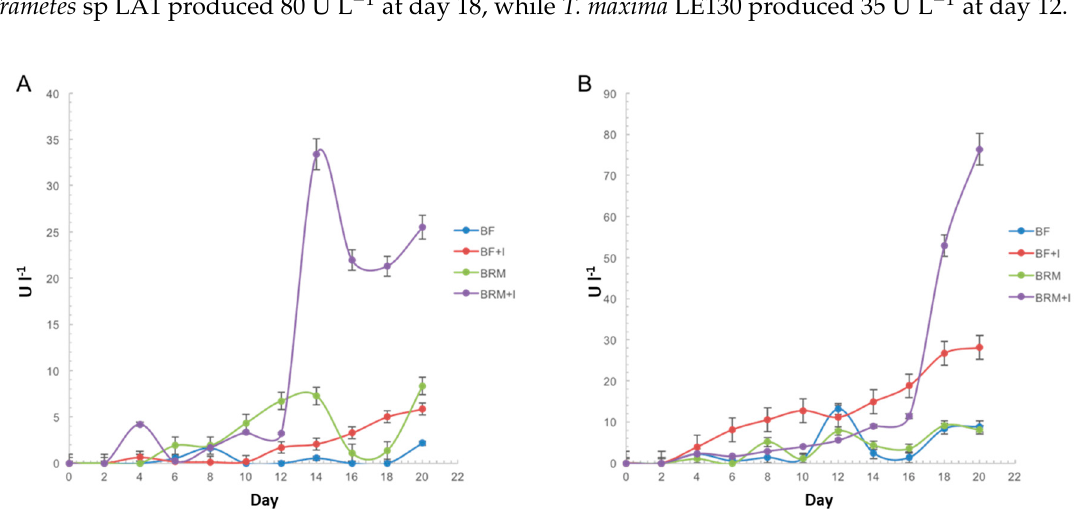
mean. a–b Means in rows with different superscripts indicate significant differences between treatments ( p ≤ 0.05).